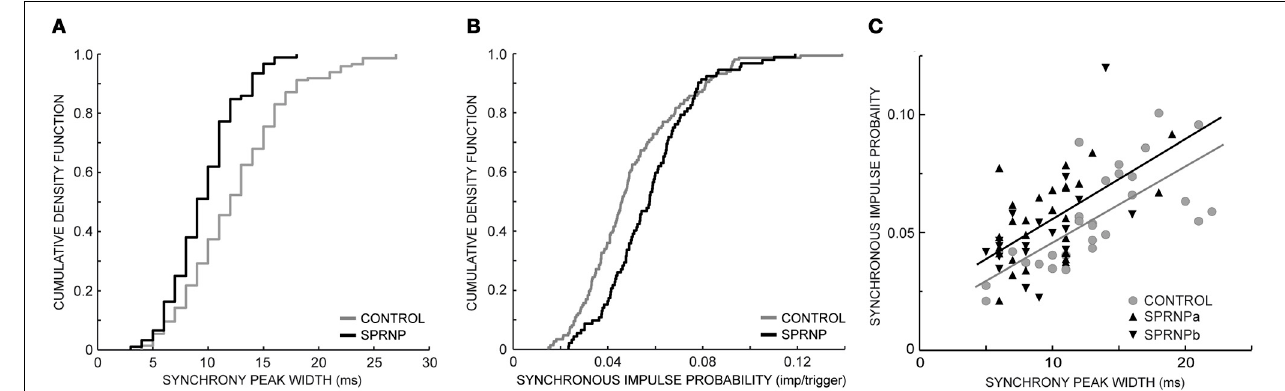
FIGURE 3 | Synchronization peak width (A) and synchronous impulse probability (B) cumulative density function (SPRNP patient and healthy subjects, black and gray staircase lines, respectively); (C) linear